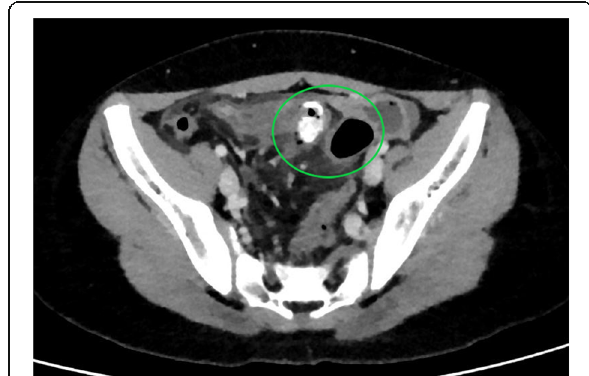
Fig. 3 CT cut illustrating the degree of inflammation around the appendicolith with extraluminal pockets of air. (Green